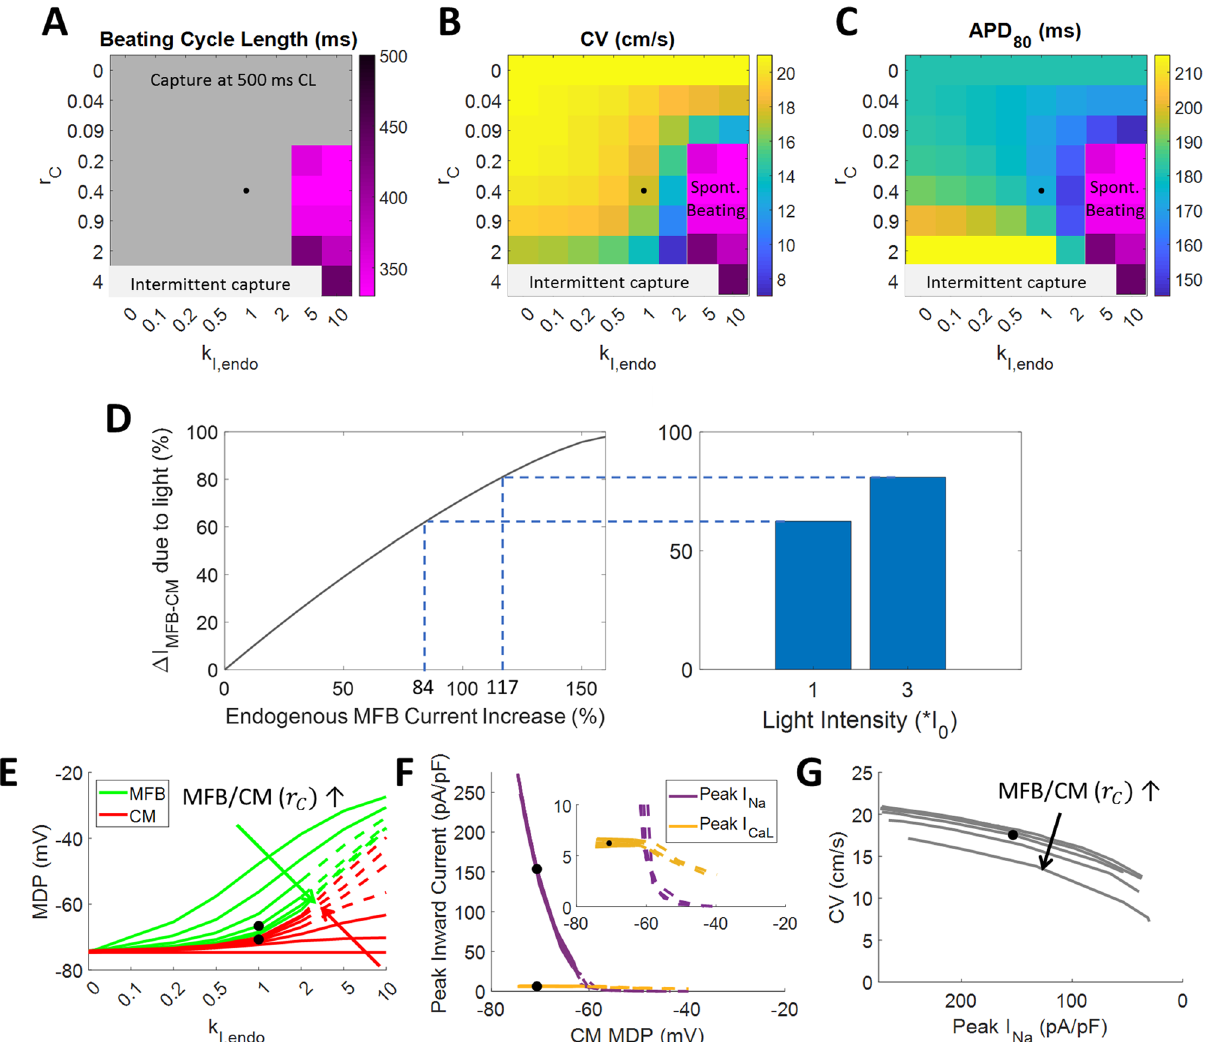
Figure 7. Modeling effects of changes in MFB/CM ratio and MFB currents. MFB-CM conductance was scaled with MFB capacitance ratio ( r C ), to model changes in MFB/CM ratio. Changes in endogenous MFB current scaling ( k I,endo , per MFB capacitance) were also modeled. Color maps show beating cycle length ( A ), conduction velocity ( B ), and APD 80 ( C ), at different MFB-CM conductances and light intensities. Parameters are varied in third-log 10 increments around the baseline values. Gray region in A denotes that spontaneous beating, if present, was slower than the 500 ms paced CL. CV and APD 80 were not calculated for the purple region in B and C since spontaneous beating prevented capture at 500 ms CL pacing. Light gray region denotes that beating occurred at less than the 500 ms paced cycle length due to intermittent capture, sometimes with spontaneous beating. Black dots indicate modeled values without light at the experimentally plated cell ratio of 0.4 and at baseline MFB conductance. ( D ) Modeling the effects of ChR2 current versus increased endogenous MFB currents showed that the light intensities used in experiments (I 0 and 3*I 0 ) resulted in the same MFB-CM current during diastole as an 84% and 117% increase in endogenous MFB currents, respectively. ( E ) Maximum diastolic potential of MFBs (green) and CMs (red). MFB line at MFB/CM capacitance ratio = 0 not shown since this implies the absence of MFBs. ( F ) Peak inward sodium current (purple) and L-type calcium current (gold) versus CM maximum diastolic potential. Inset shows same data with an expanded scale. ( G ) Conduction velocity versus peak sodium current. ( E–G ) MFB-CM capacitance ratio starts at 0 then increases by third-log 10 increments from 0.04 to 2. Solid lines show conditions that allowed capture at the 500 ms paced CL. Dashed lines show conditions that caused spontaneous beating in excess of the pacing rate. Black dots indicate modeled values without light at the experimental MFB/CM cell ratio of 0.4 and at baseline MFB current level (i.e. the same as the black dots in Fig.